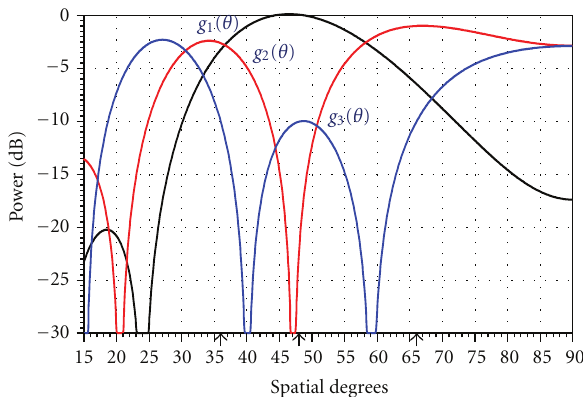
Figure 6: Retrodirective eigenvector beams g 1 ( θ ), g 2 ( θ ), and g 3 ( θ ) for continuously distributed jammers in the sidelobe region from 30 ◦ to 90 ◦ of 8-element linear array; compare [55].